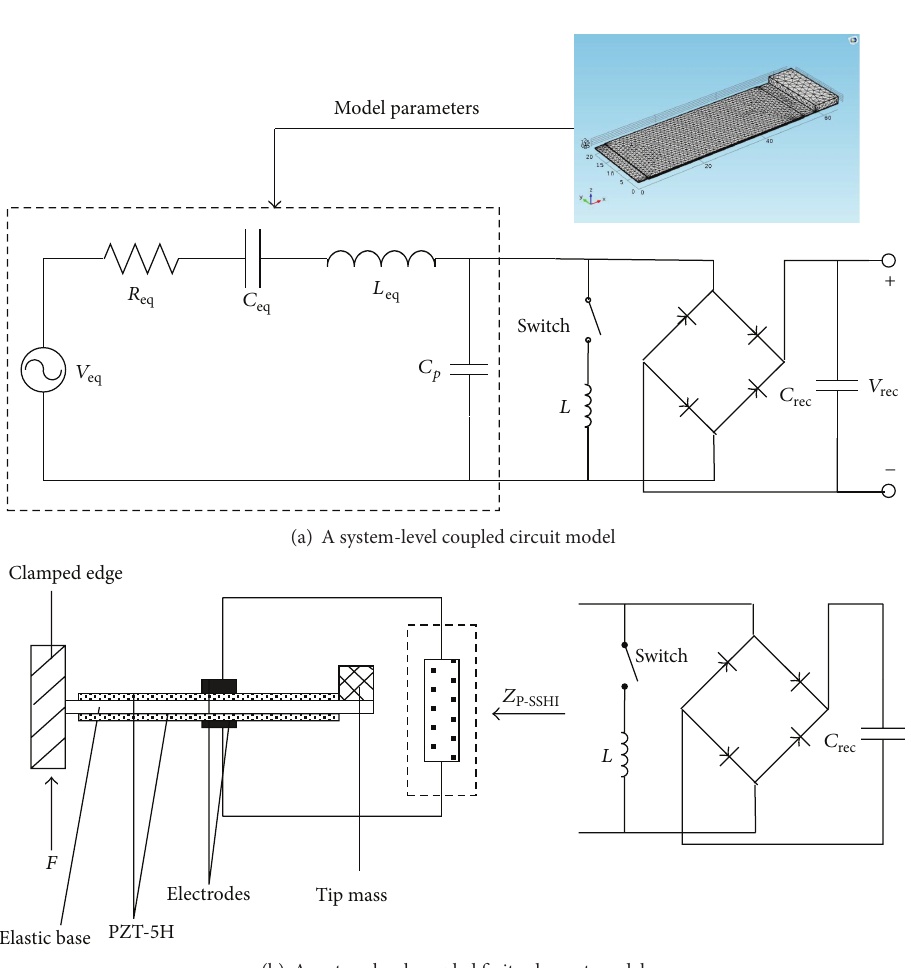
Figure 4: Schematic diagrams of the proposed two classes of coupled models.